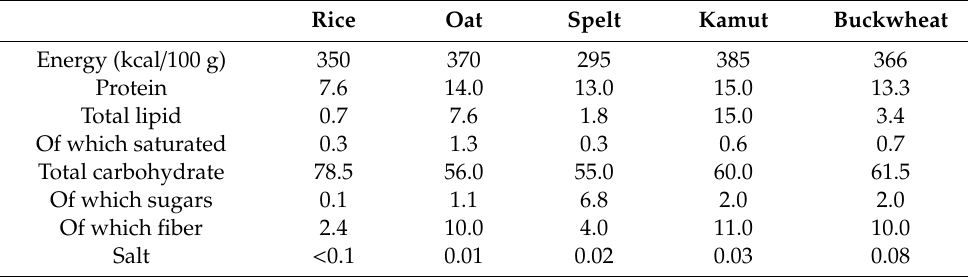
Table 1. Nutritional composition of the five di ff erent flours used in the cookies’ formulations (g / 100 g of flour). Values were provided by the suppliers Ceifeira and Pr ó vida. Rice Oat Spelt